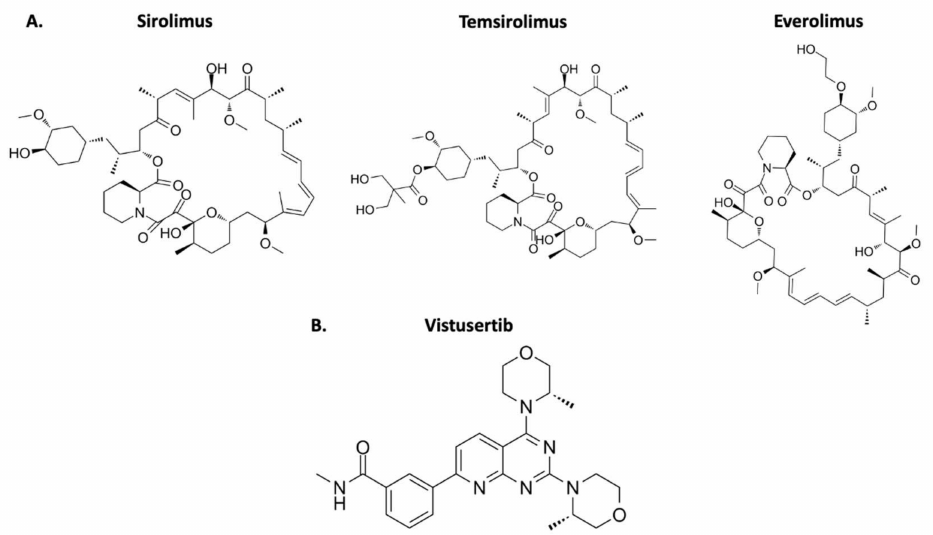
Figure 2. Chemical structure of mTOR inhibitors approved by the FDA. ( A ) The first-generation mTOR inhibitors that target mTORC1. ( B ) The second-generation mTOR inhibitor that targets mTORC1 and mTORC2. It is not yet FDA-approved for any treatment course [47–50]. Overall, the therapeutic targeting of mTOR in chemotherapy relies principally on the inhibition of mTORC1. Nevertheless, an understanding of the biology underlying mTORC2 can explain drug resistance and could lead to the development of effective alternatives